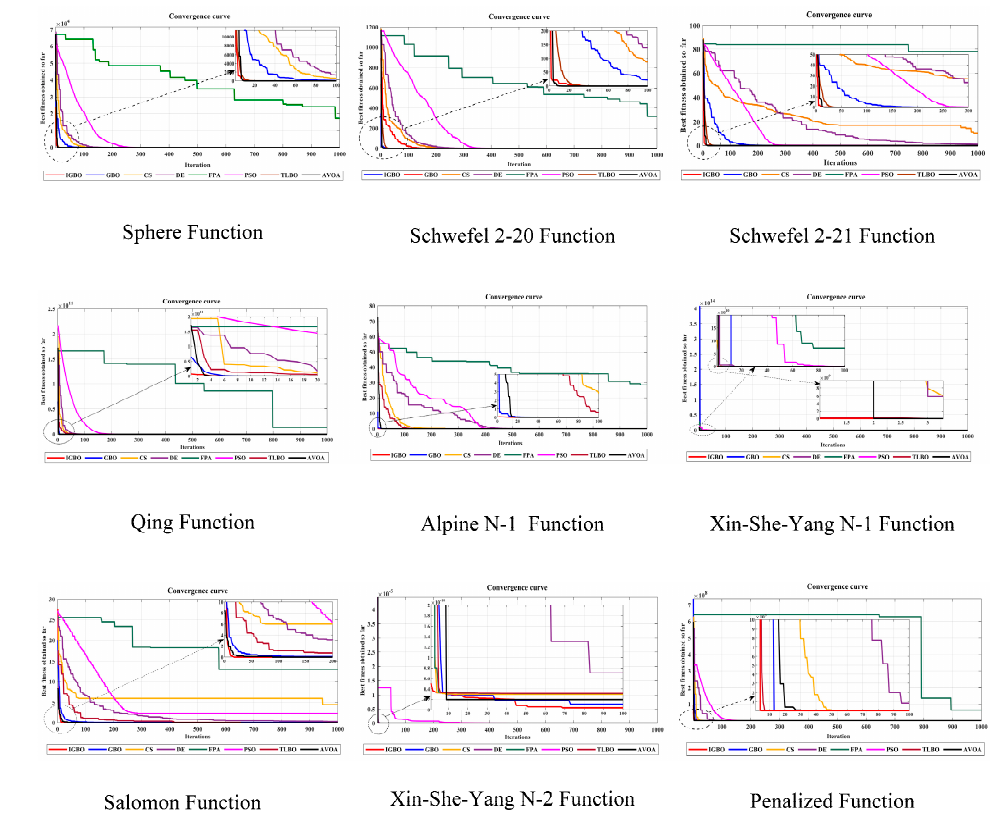
Figure 8. Convergence curve of the functions.